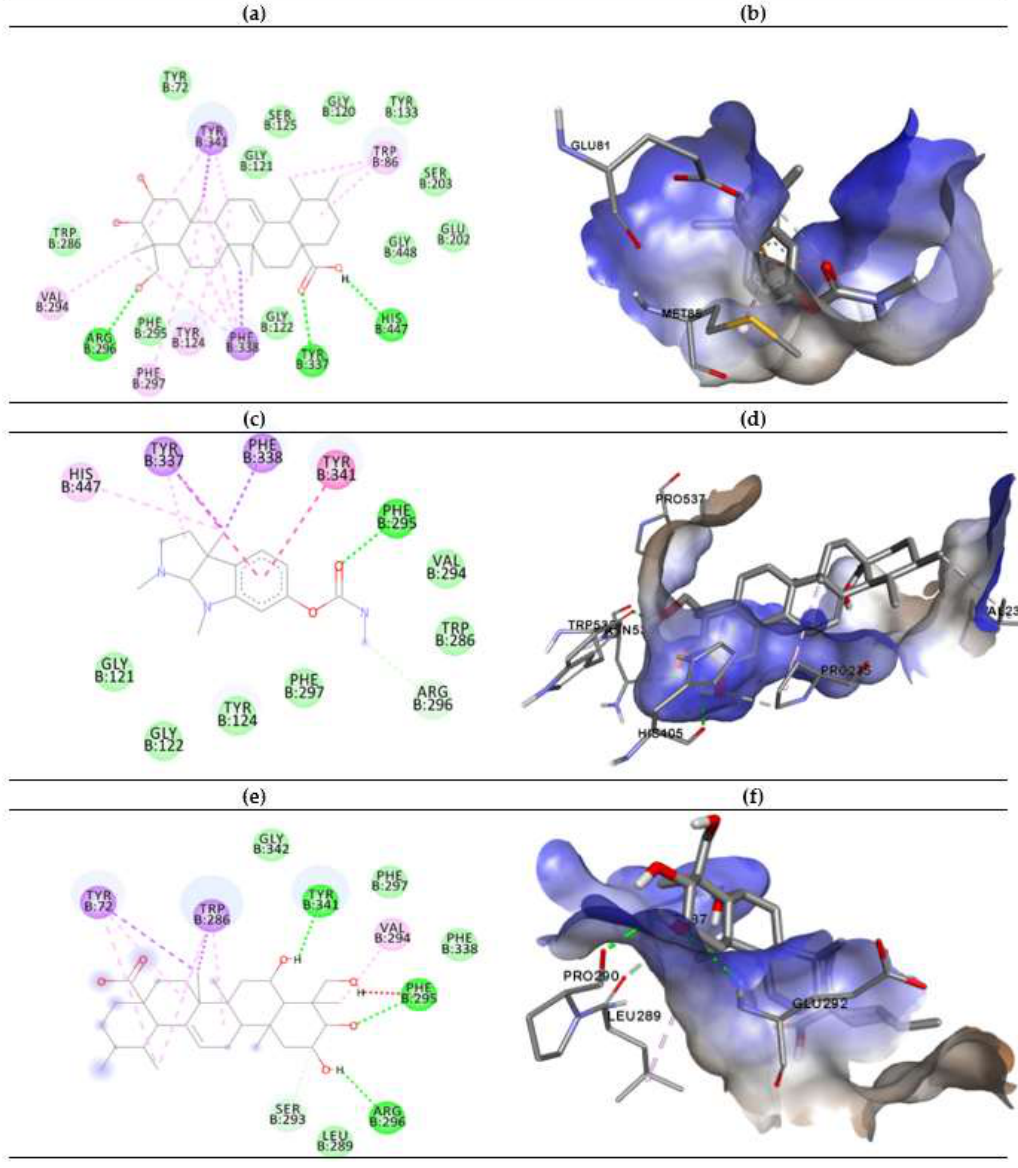
Figure 3. The 2D binding poses representation of compounds ( a ) eserine, ( c ) asiatic acid, and ( e ) madecassic acid with the active sites of AChE. The green dotted lines indicate hydrogen bonds, while π - π stacking and π -sigma interactions are presented in both strong and light magenta between compounds and AChE. The hydrophobic interactions of compounds ( b ) eserine, ( d ) asiatic acid, and ( f ) madecassic acid against AChE.